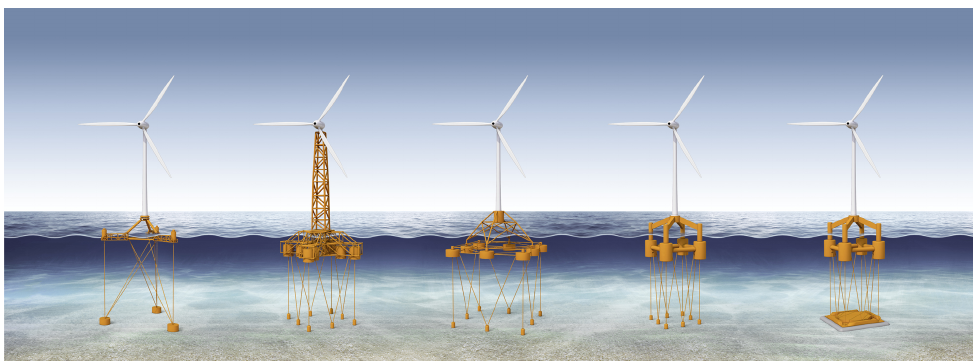
Figure 3. The development path of the GICON ® -TLP, from